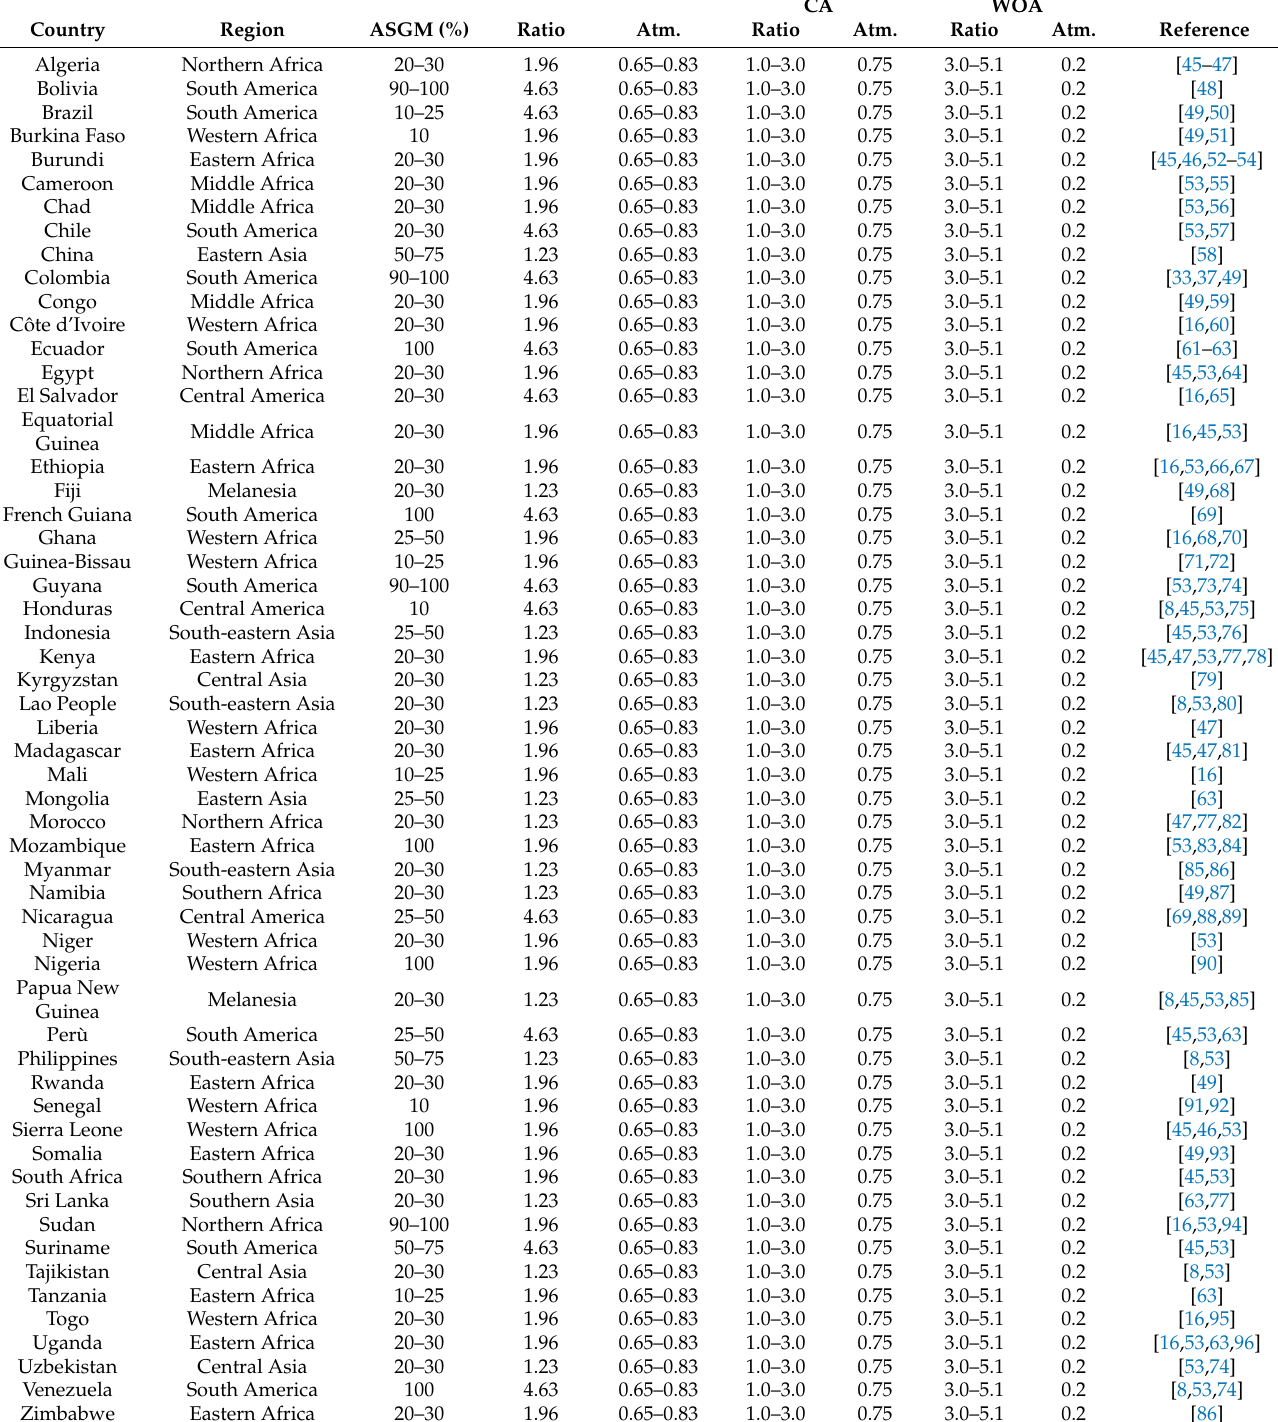
Table 1. The combination of parameters used in this study for the bootstrap-based estimates of Hg emissions from ASGM. “Atm” indicates the fraction of Hg emitted into the atmosphere.